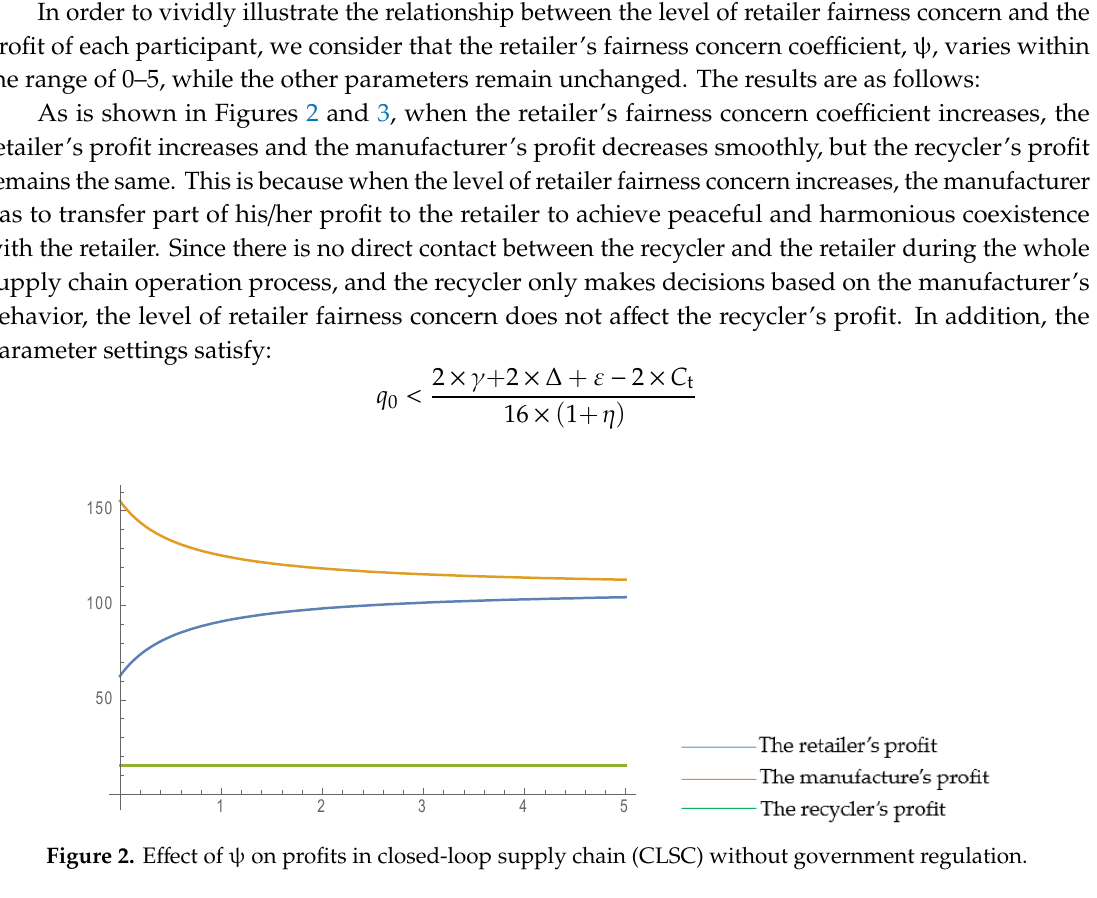
Figure 3. Effect of  on profits in CLSC with government regulation. Figure 4. Effects of  and q 0 on each member’s profit in CLSC.